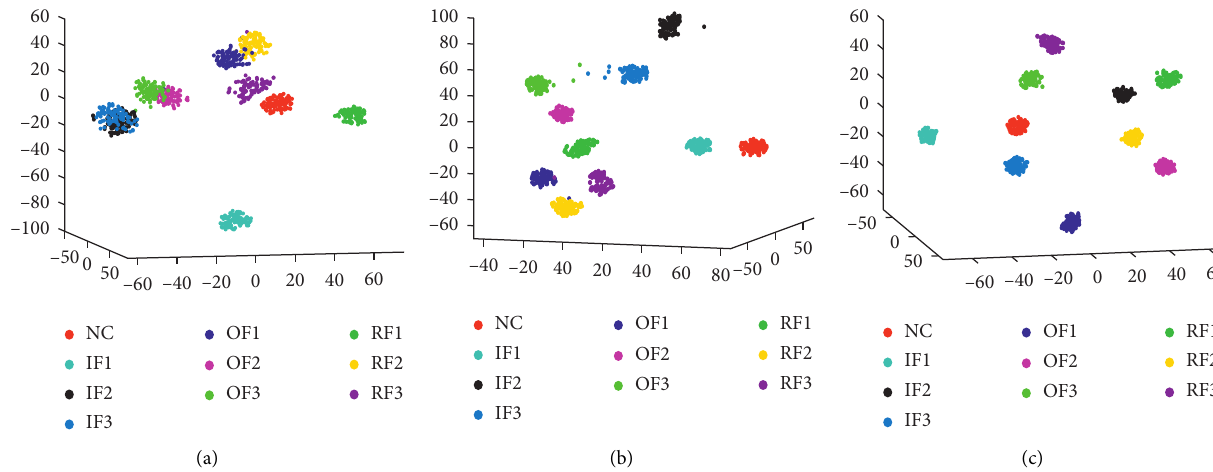
Figure 6: Comparison of dimensionality reduction visualization results on Dataset A. (a) GAN-SAE. (b) WGAN-SAE. (c) WGAN-GP-SAE.